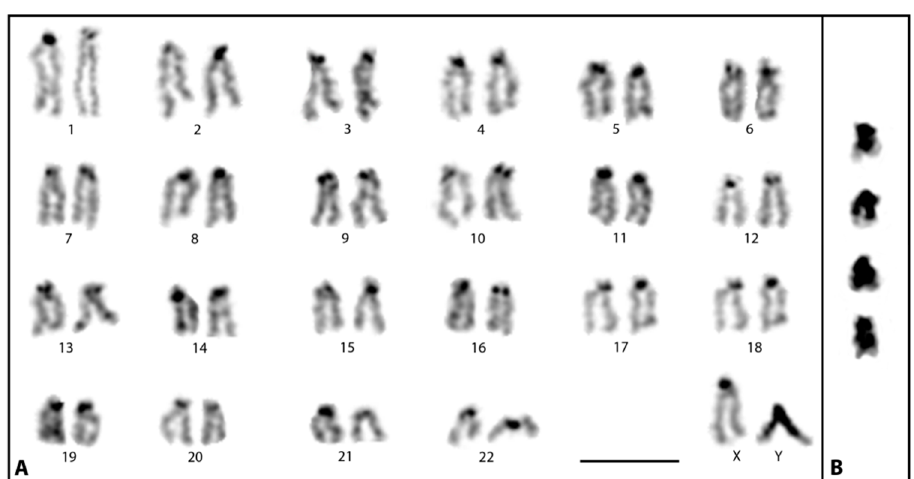
Figure 2. Heterochromatin staining of M. picta metaphase chromosomes. ( A ) C-banded karyotype of male displaying the heterochromatic region on the Y chromosome. ( B ) C-banded Y chromosome cut-outs from different metaphases. Note a short non-heterochromatic region at the very distal region of the long arm of the Y. Bar: 3 µm.